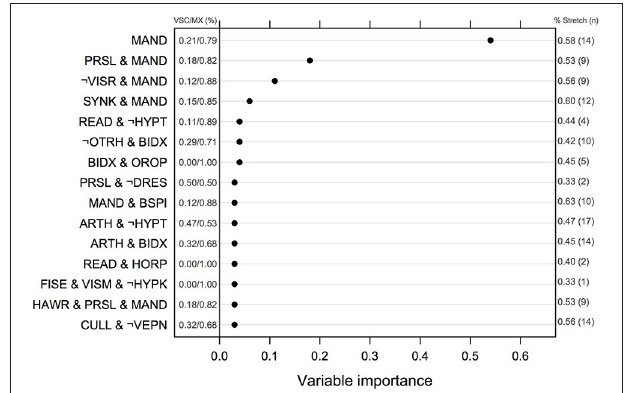
FIGURE 2 | Normalized measures of variable of importance from the Logic Forest classifier on the full sample ( N = 58 ). The frequency of impairment for MX and VSC children is shown on the left part of the figure. The symbol ¬ indicates logical negation, which means no failure in this case. VSC, Visuo-spatial/visuo-constructional subtype DCD; MX, Mixed subtype DCD.